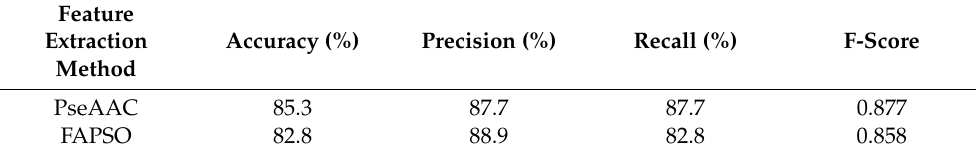
Table 4. GPCR classification performance for subfamily level.